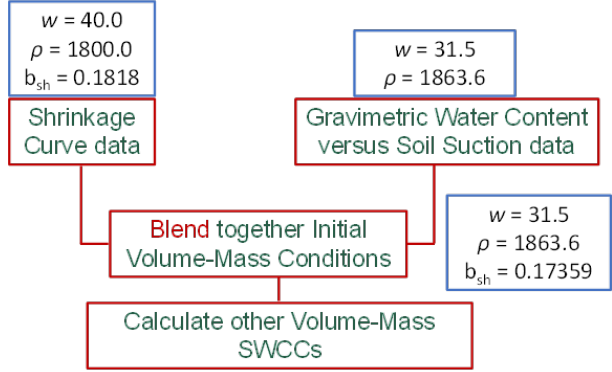
Figure 12. Blending of the initial volume-mass properties on the SC and w-SWCC specimens.